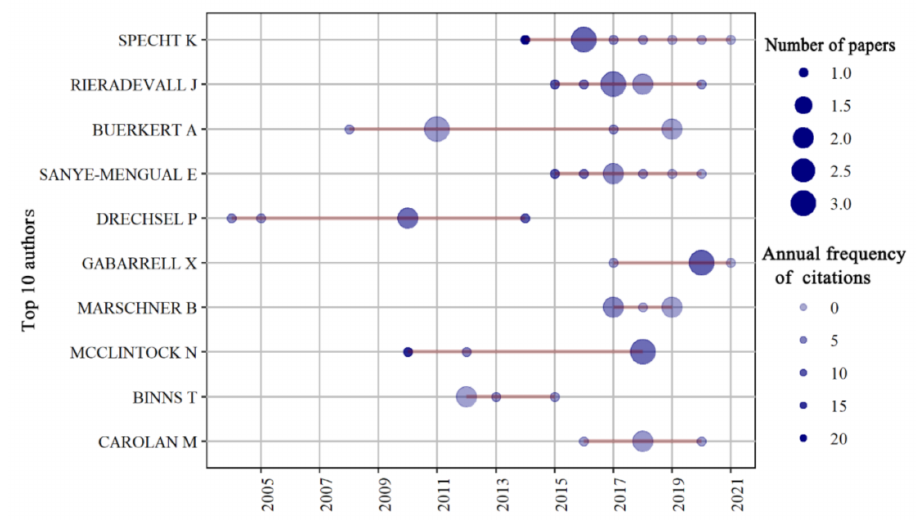
Figure 4. Top 10 authors’ productivity in the field of urban agriculture from 2001 to